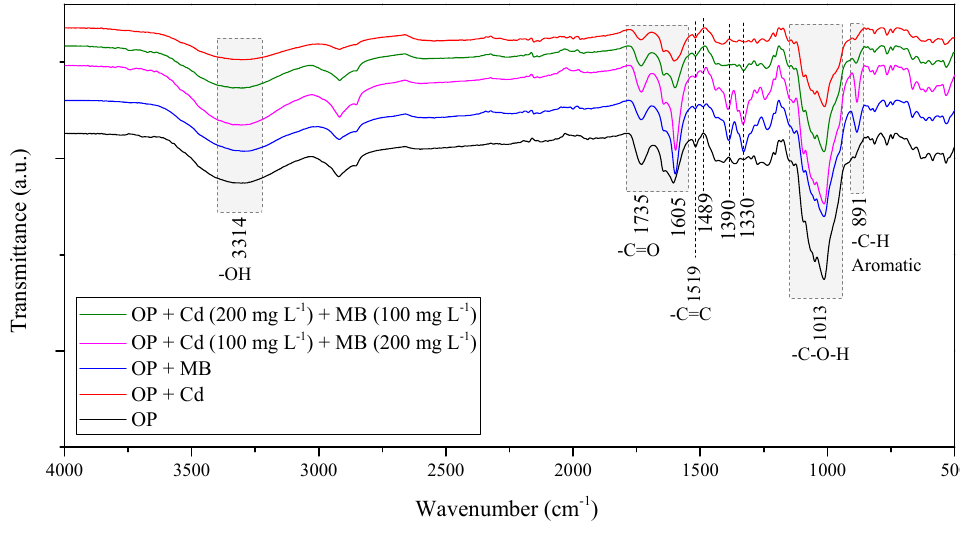
Figure 6. FTIR spectra of the OP before and after adsorption. Table 4. FTIR bands before and after adsorption.